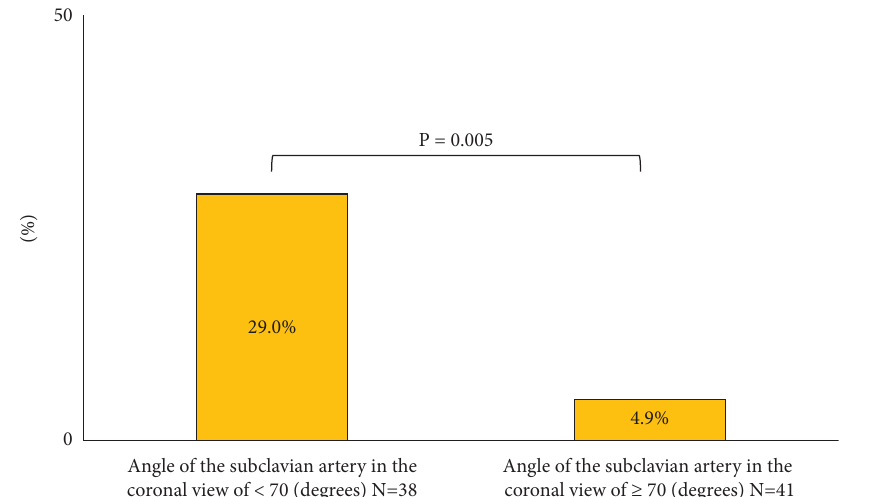
Figure 5: Incidence of contrast-induced nephropathy. Contrast-induced nephropathy occurred more frequently with an angle of the subclavian artery in the coronal view of < 70 degrees than of ≥ 70 degrees (11 patients; 29.0% vs. 2 patients; 4.9%, P � 0 .